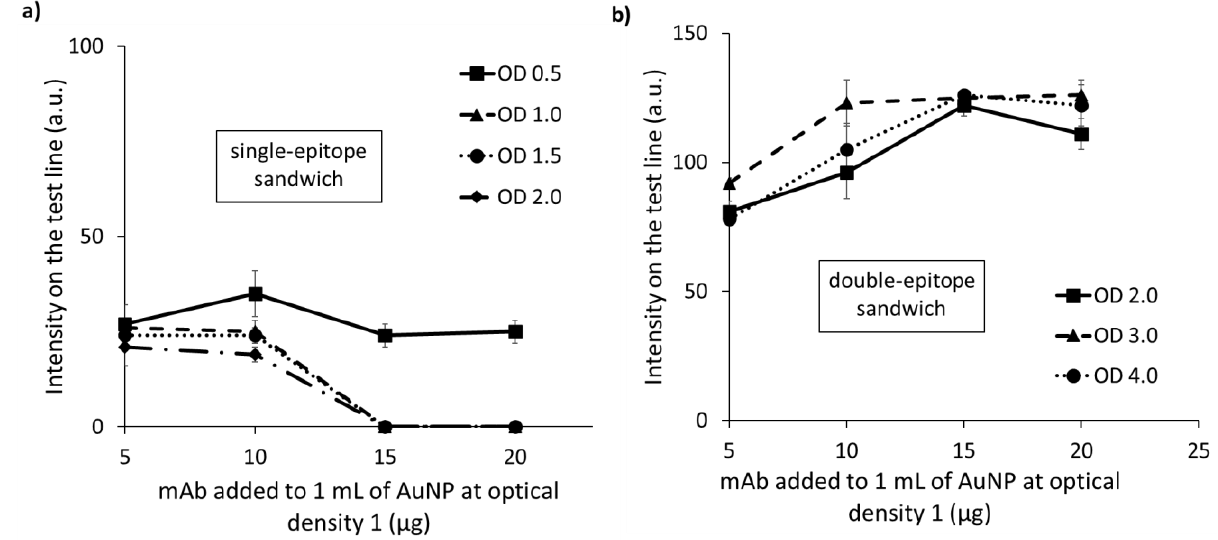
Figure 3. Intensity map for the 32 nm AuNPs with increasing amounts of #2F10_AuNP (optical density 0.5-1-1.5-2 for the SE ( a ) and 2-3-4 for the DE ( b )) and antibody adsorbed to the surface of the AuNPs (5-10-15-20 µg for each mL of AuNP at optical density 1).